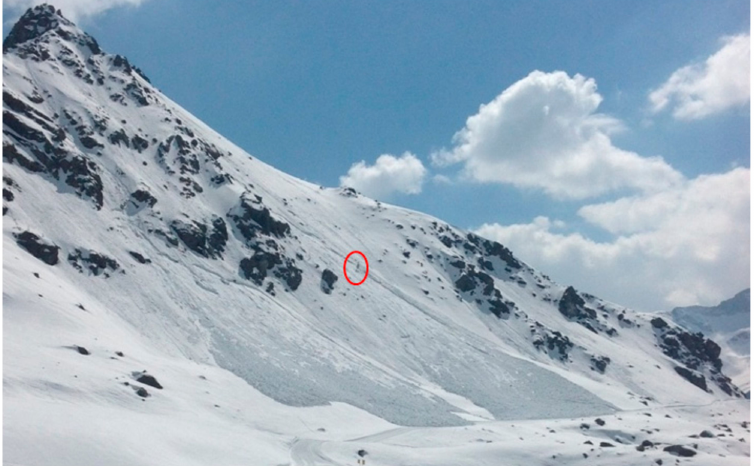
Figure 7. Overview of the 17 April 2013 avalanches. The red circle highlights the obstacle. Photo A. Welf.